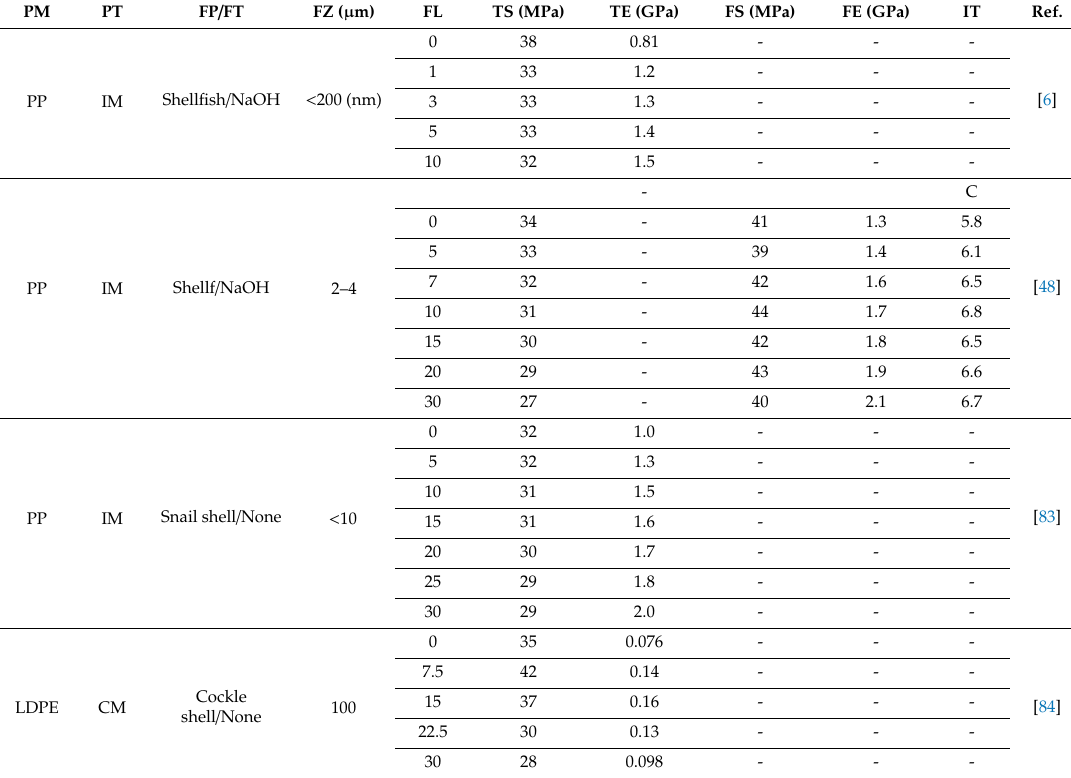
Table 6. Summary of thermoplastic polymers containing bio-calcium carbonate